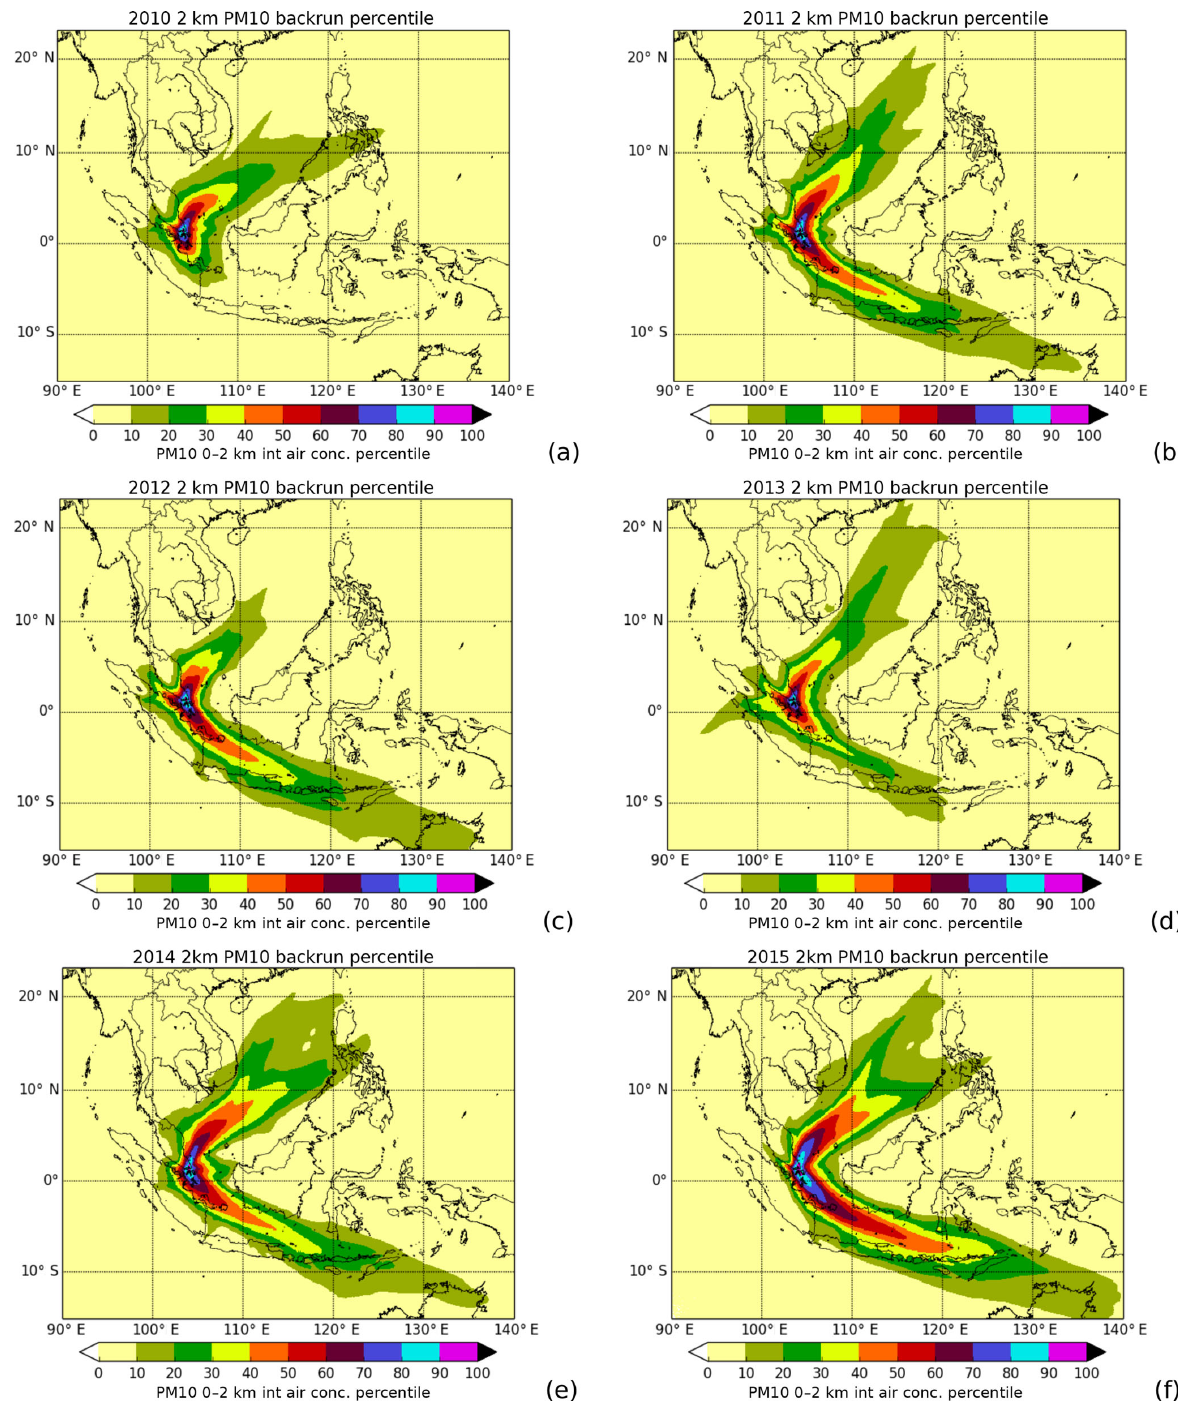
Figure A2. Air history maps for the years 2010 to 2015, showing where air arriving in Singapore during each year originated from. The backruns shown were conducted from a receptor site in central